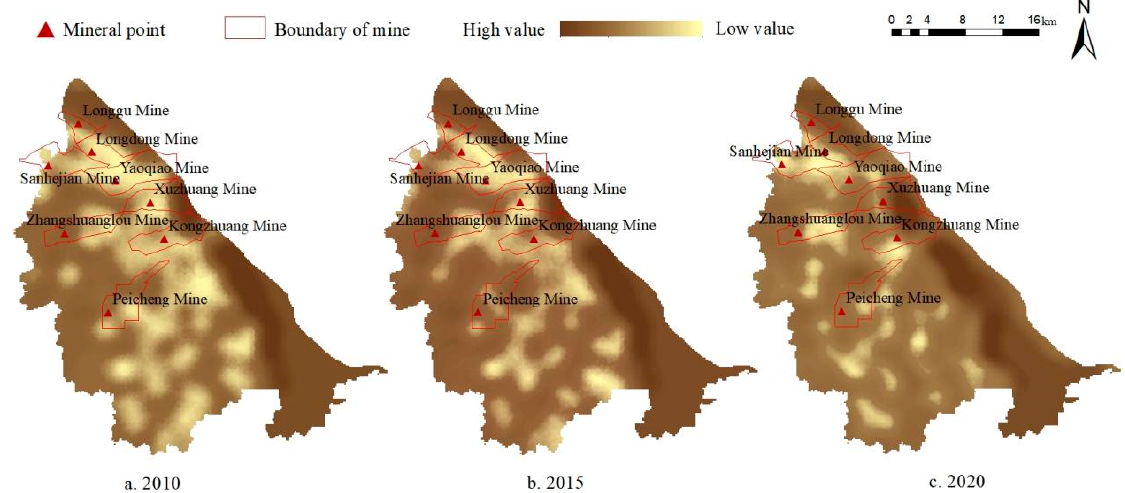
Figure 5. Spatial distribution of spatial–temporal heterogeneity in 2010, 2015, and 2020.